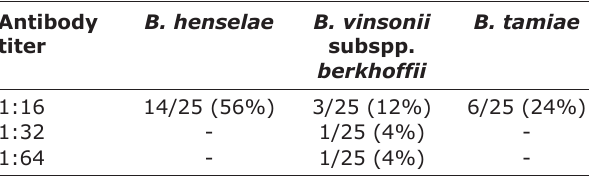
Table-1: Seroprevalence of antibodies against B. henselae, B. vinsonii subspp. berkhoffii, and B. tamiae by IFA.